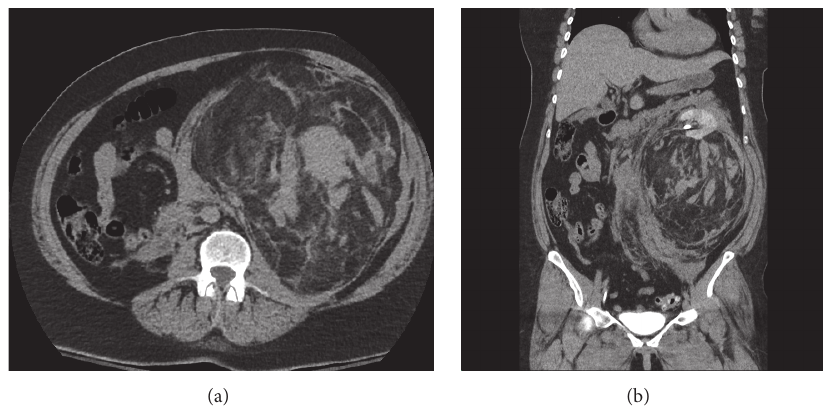
Figure 1: Axial (a) and coronal (b) views of abdominal CT showing massive perinephric